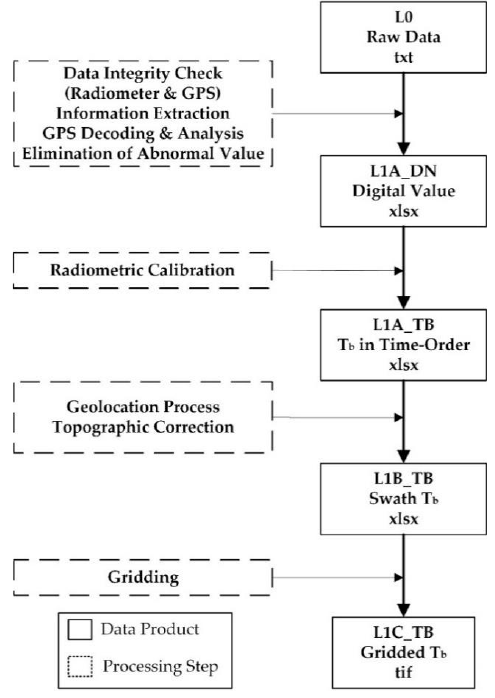
Figure 5. Diagram of the radiometer data processing.